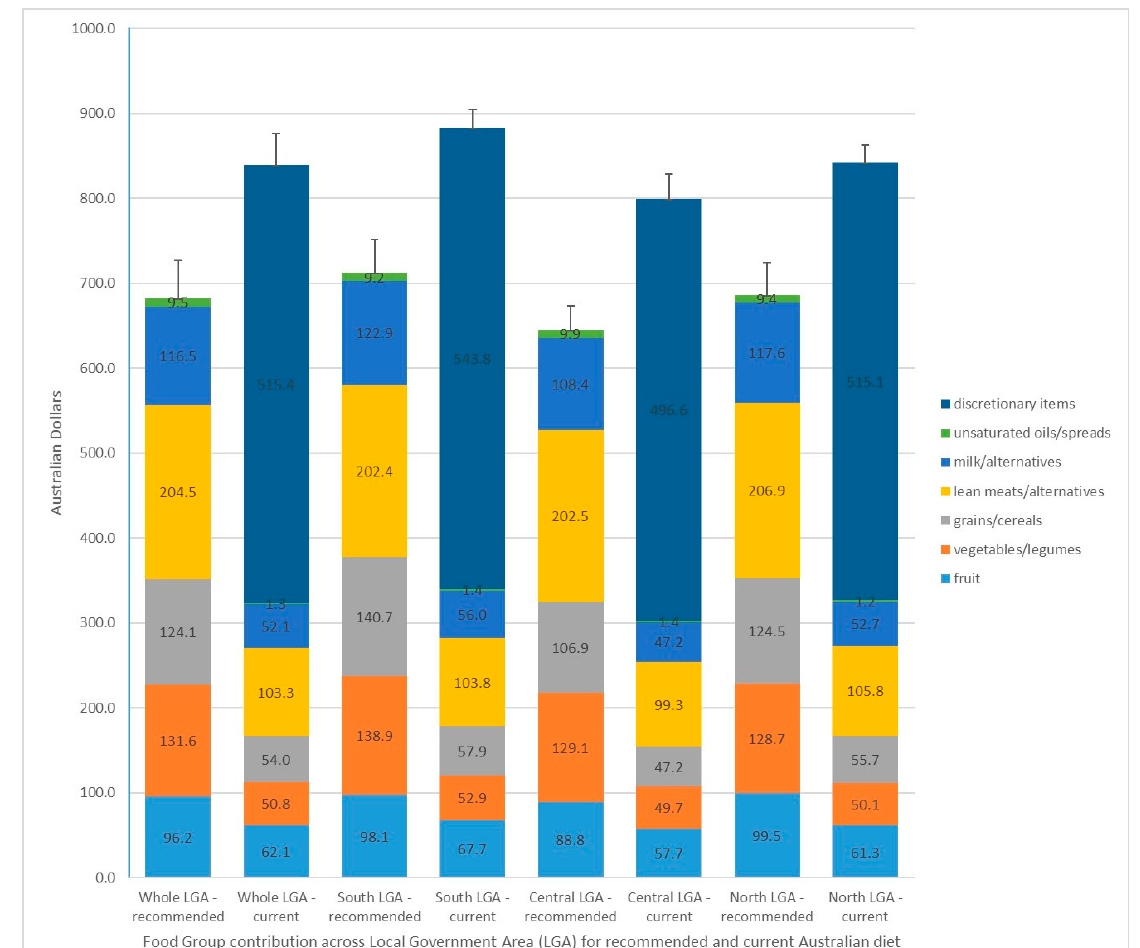
Figure 2. Food group contribution and total diet costs for recommended and current diets for the Local Government Area ($AUDmean ± SD per fortnight).